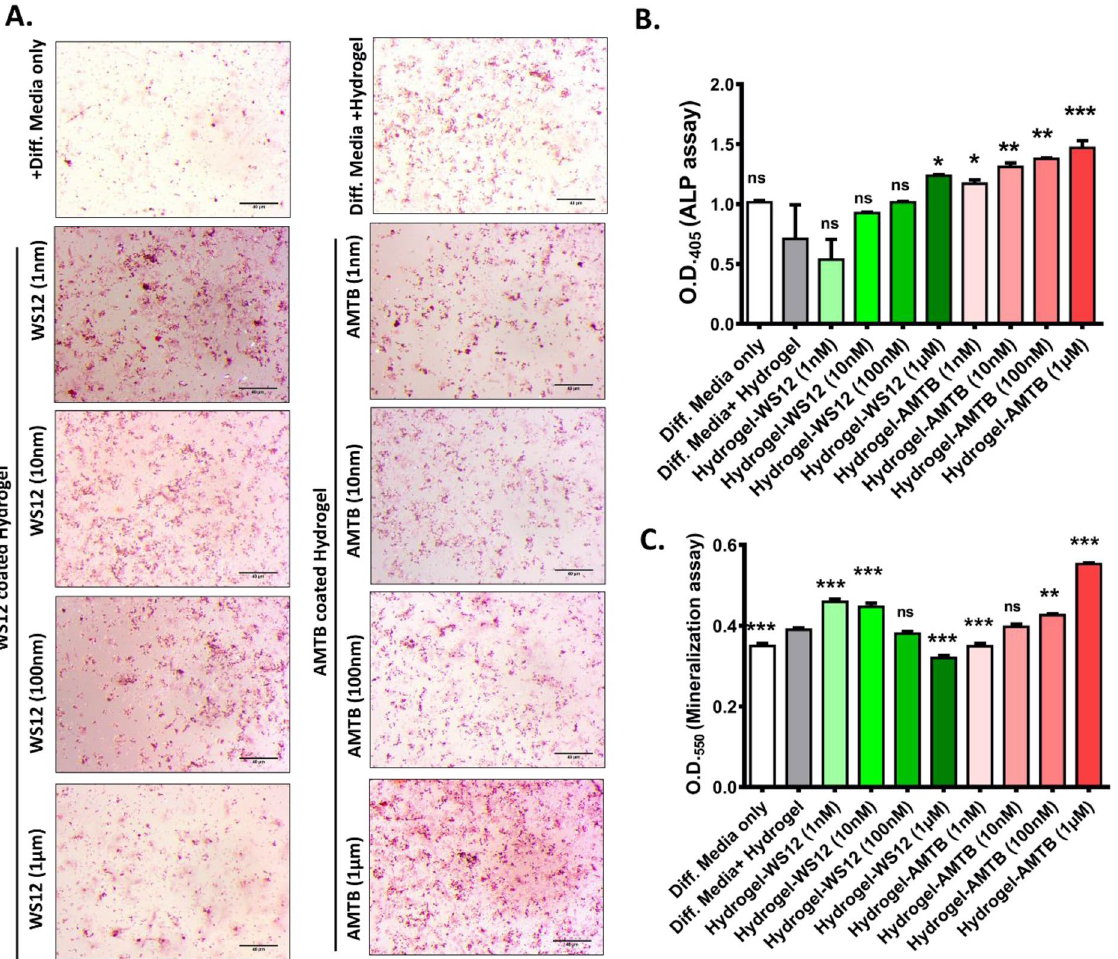
Figure 6. Hydrogel (CMT:HEMA)-mediated release of TRPM8 agonist and antagonist modulates osteoblasts functions. ( A) Photographs (upper panel) represents mineralization nodules of Mesenchymal Stem Cells (MSCs) grown for 15 days in absence or presence of hydrogel (CMT:HEMA) as detected by Alizarin Red staining (n = 3). The lower panel photographs represent the extent of mineralization nodules formed when cells were grown on WS12 or AMTB encapsulated CMT:HEMA hydrogel. Scale bar 40 µm. ( B,C) Bone marrow- derived Mesenchymal Stem Cell population (BM-MSCPs) grown on these hydrogels or hydrogels-encapsulated with AMTB or WS12 reveals dose-dependent differentiation (B) and mineralization (C) (n = 3). The significance values are as follows: ANOVA test, p values: * < 0.05, ** < 0.01, *** <